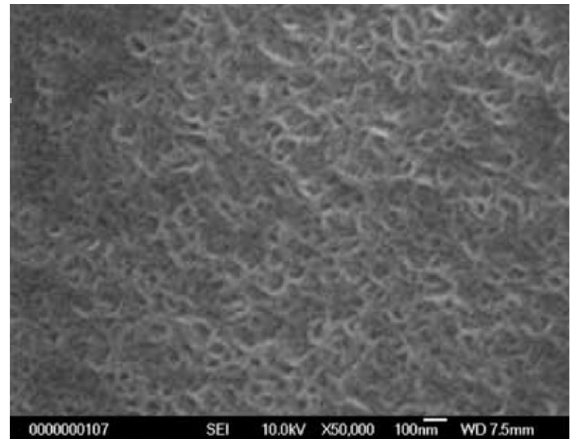
Figure 2. SEM photograph of ITO thin film prepared by spray sprolysis method.